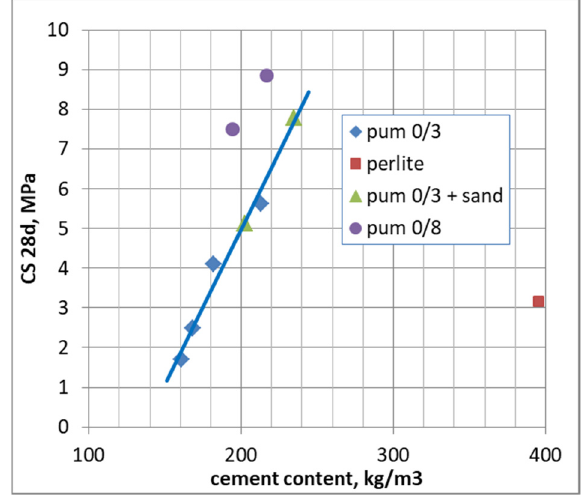
Figure 1. Strength of lightweight concrete vs. the applied pumice concrete vs. cement content.